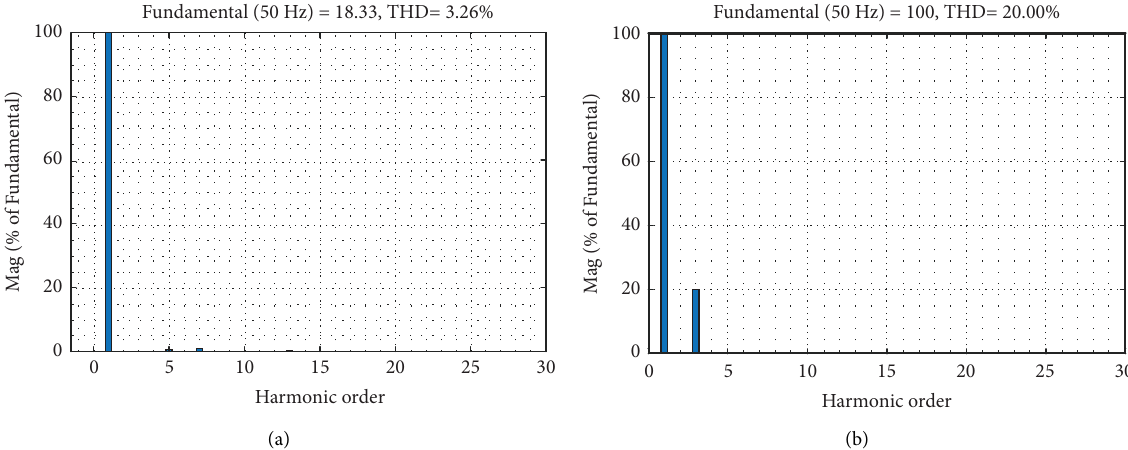
Figure 15: THD analysis of (a) grid current and (b) grid voltage, under unbalanced grid source voltage.